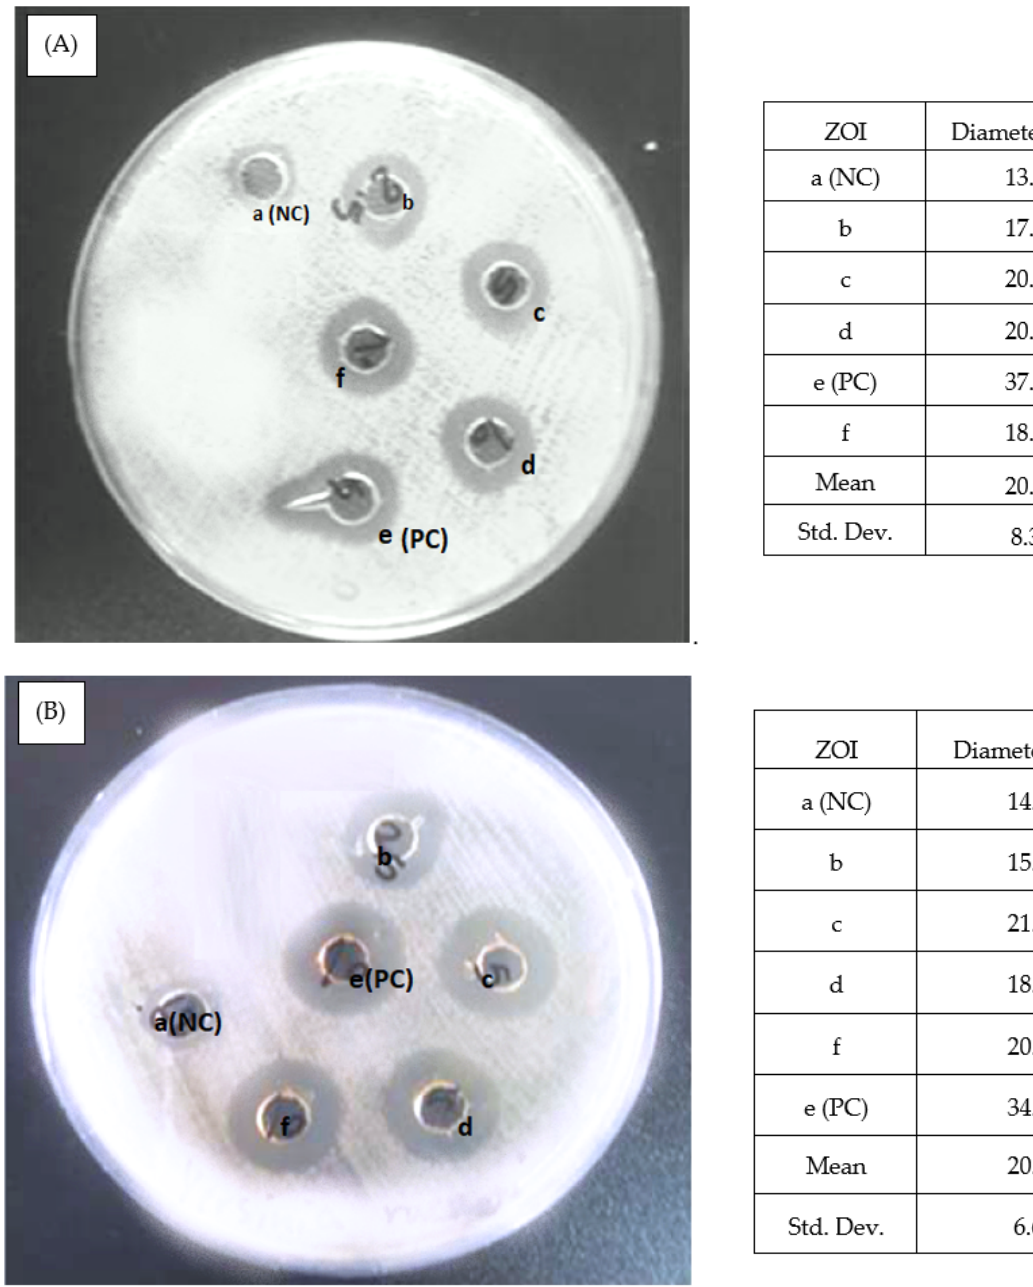
AgNPs [43]. Antibacterial activity is well established comparing with Gram-negative and Gram-positive bacteria. As observed in Figure 8, both bacterial strains showed the mean value of ZOI with slight differences.